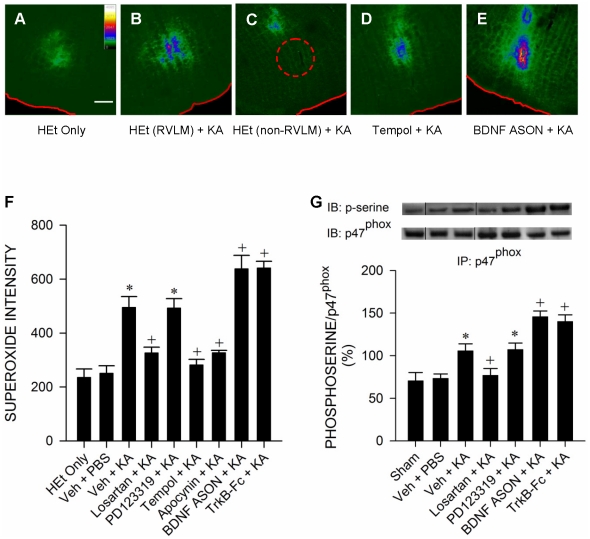
Oxidative stress in RVLM during experimental TLSE.(A–E) Representative photomicrographs showing the relative intensity (inset) of fluorescence emitted by 2-hydroxyethidium, the specific reaction product between superoxide and hydroethidine (HEt), which was microinjected into RVLM (B) or immediately outside RVLM (C) before application of KA (0.5 nmol) into the left hippocampal CA3 subfield of animals that received pretreatment by microinjection into the bilateral RVLM of distilled water or 0.1 M PBS (Veh) (B,C), tempol (D) or an antisense oligonucleotide (ASON) against bdnf gene (E). Note minimal fluorescence when HEt was applied to RVLM in animals that received no further experimental manipulations (A). Scale bar, 200 µm. Note that the relative position of RVLM in (C) is denoted by a circle in dashed line. (F–G) Summary of relative intensity of superoxide anion based on 2-hydroxyethidium fluorescence at RVLM (F) or the percentage of phosphoserine (p-serine) relative to p47phox obtained from the cytosolic fraction of proteins extracted from RVLM that were immunoprecipitated by an anti-p47phox antiserum, followed by Western blot analysis of p-serine or p47phox, 180 min after microinjection of KA (0.5 nmol) or PBS into the left hippocampal CA3 subfield of animals that received pretreatment by application into the bilateral RVLM of distilled water, 1% DMSO or 0.1 M PBS (Veh), losartan (2 nmol), PD123319 (2 nmol), tempol (200 pmol), apocynin (2 nmol), BDNF ASON (100 pmol) or a recombinant human TrkB-Fc fusion protein (TrkB-Fc; 1.5 pmol). Values are mean ± SEM from 5–7 animals per experimental group.*P<0.05 versus HEt alone or Veh+PBS group, and +
P<0.05 versus Veh+KA group in the post hoc Scheffé multiple-range test. Note that in (G), dividing lines are placed on the gel images to denote groupings of images from different parts of the same gel or from different gels. Note also that since similar results were obtained from 0.1 M PBS, 1% DMSO or distilled water pretreatments, they were represented collectively by Veh in this and Figures 4–5 and 7–

12 for clarity.